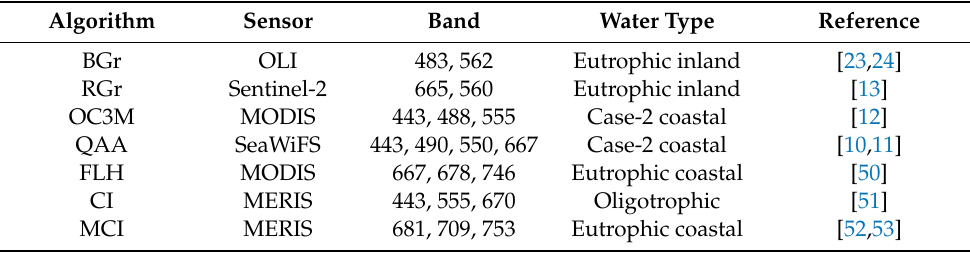
Table 3. The common algorithms and spectral bands (in nanometers) for Chl-a concentration retrieval.